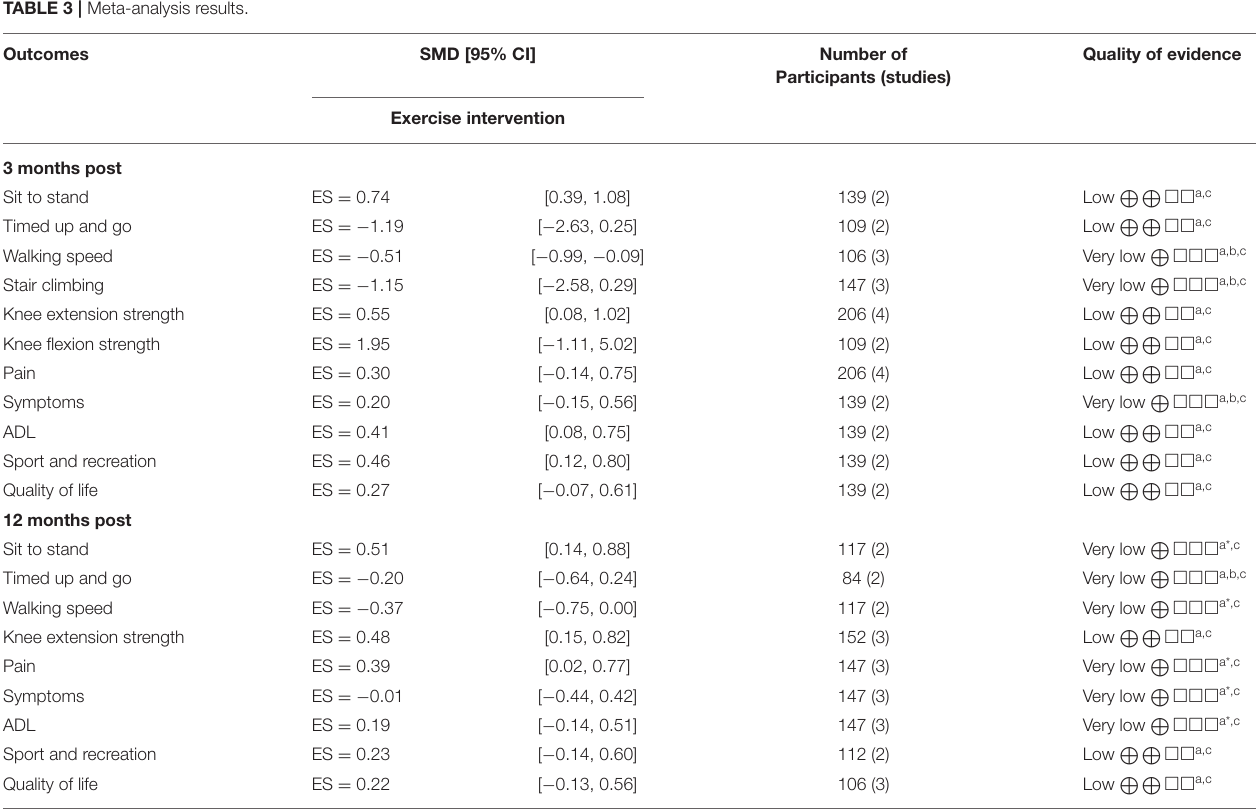
TABLE 3 | Meta-analysis